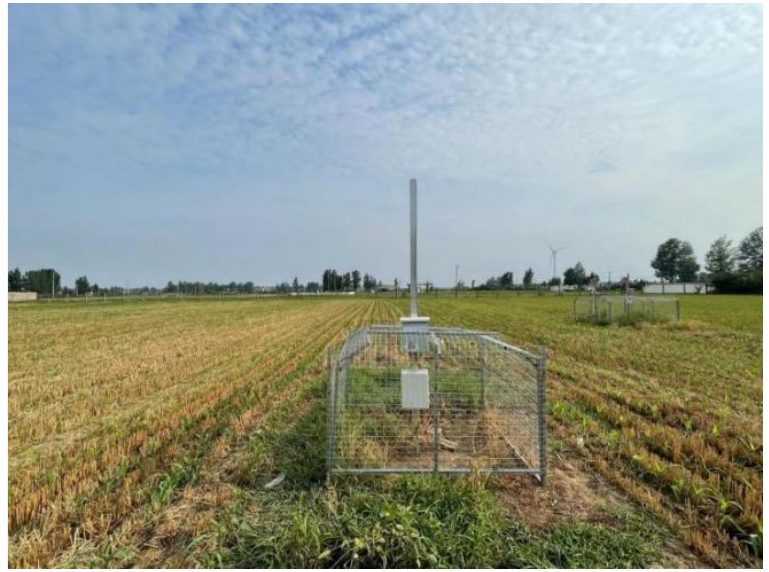
Figure 1. Surrounding environment of the observation station, located in Xinxiang City, Henan Province, China.